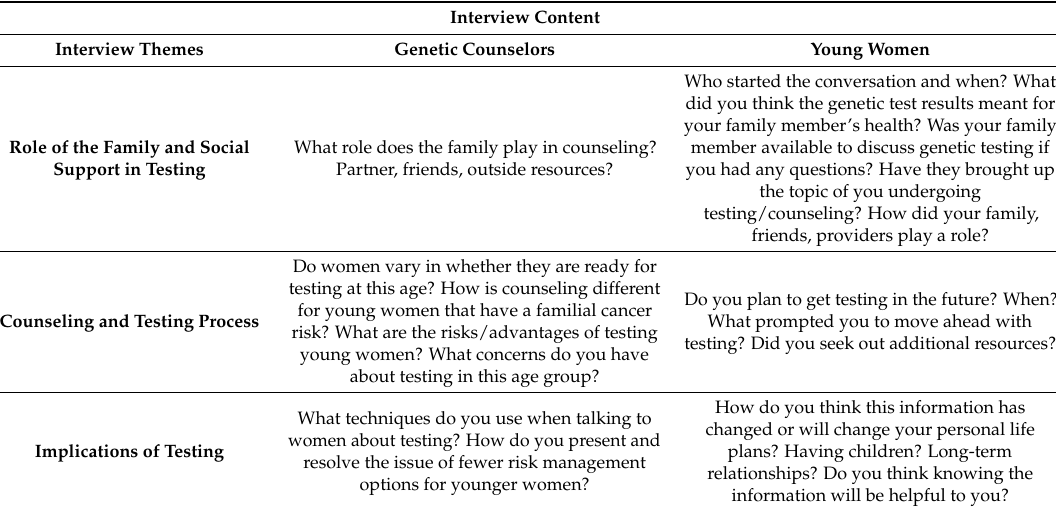
Table 1. Interview